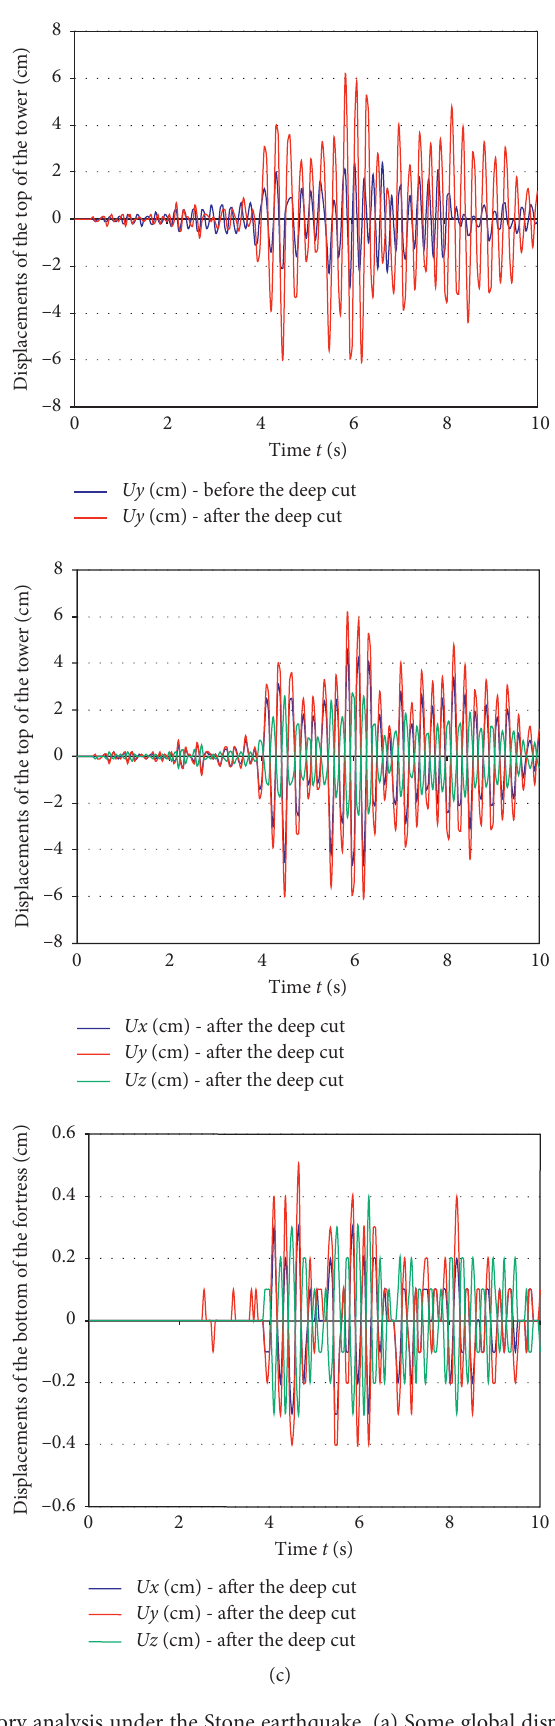
Figure 12: Some results for time history analysis under the Stone earthquake. (a) Some global displacements for the Stone earthquake at t � 5.85 s and t � 6.20 (s). (b) The principal tensile strains (cracking zones) at t � 6.2s for the Stone earthquake, view from the north. (c) Some characteristic displacements of the north-western facade of the fortress over time for the Stone